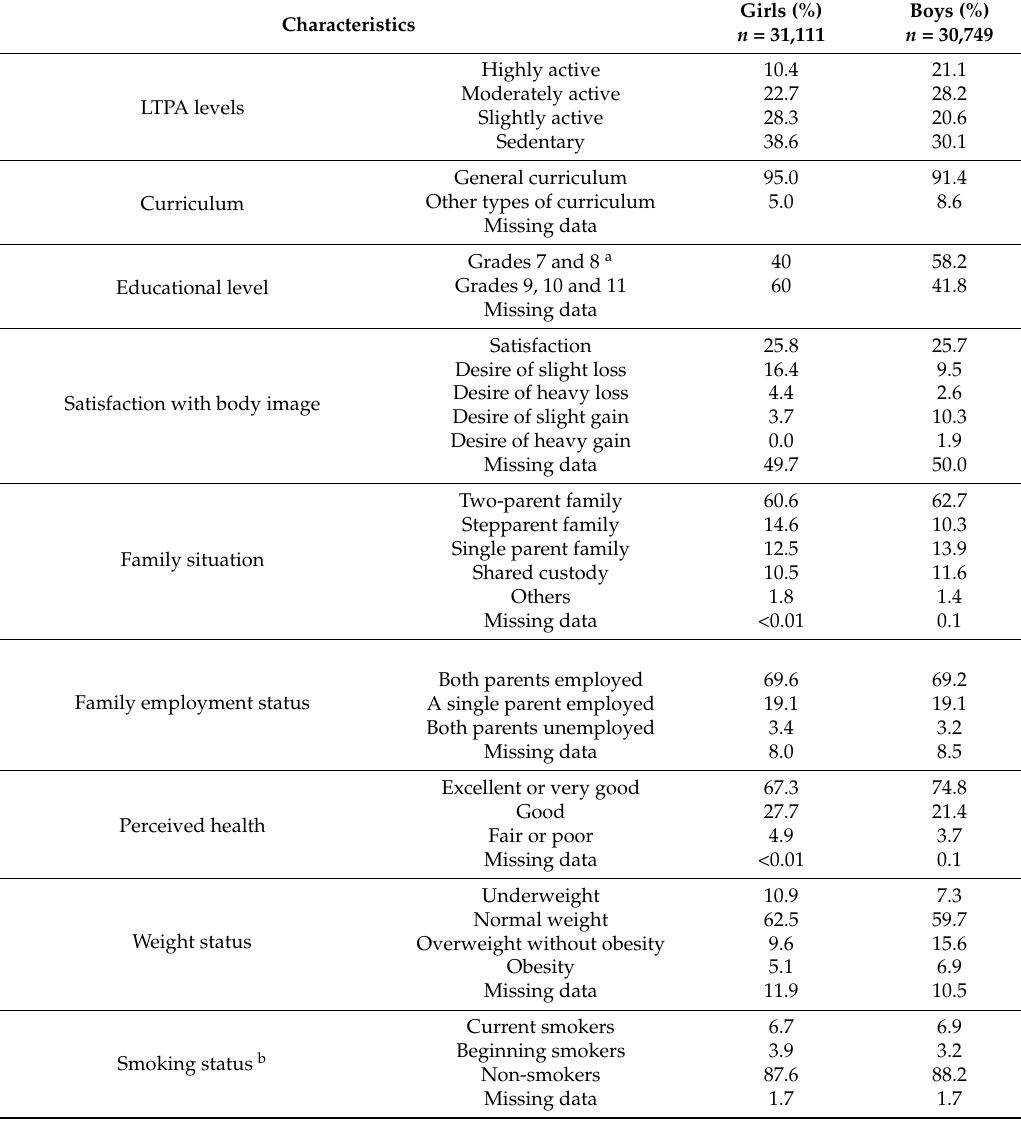
Table 1. General Characteristics of the Students Involved in the QHSSHS, Quebec,